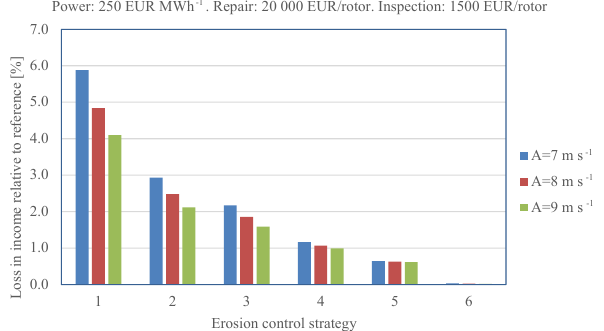
Figure 19. Loss of income due to erosion, inspection and repair. Energy: 50EURMWh − 1 . Repair: 20000EURrotor − 1 . Inspection: 1500EURrotor − 1 .